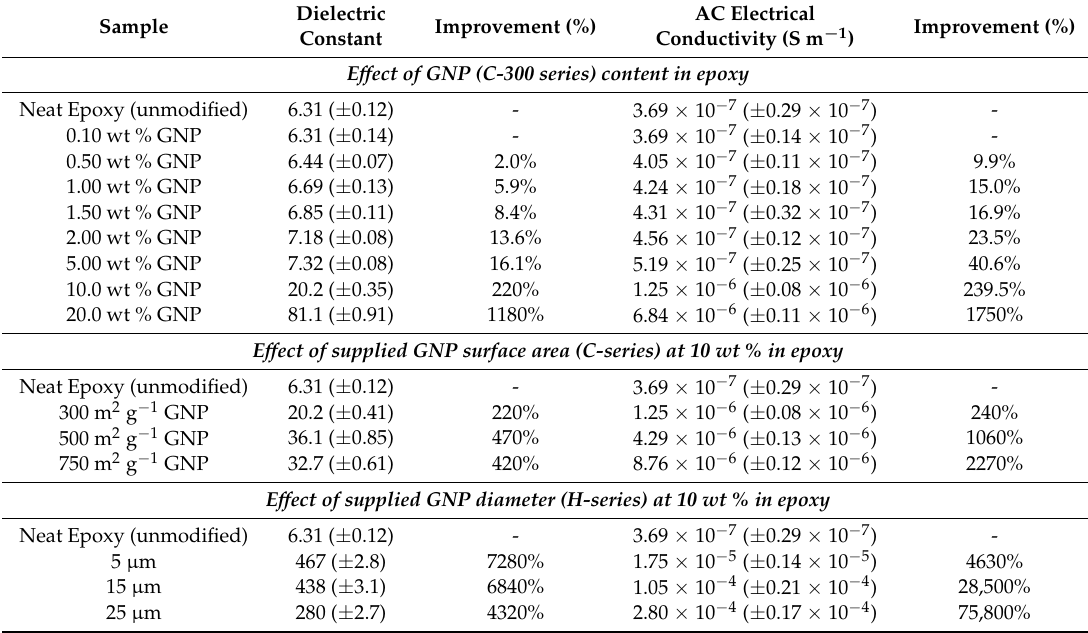
Table 1. Dielectric constant and AC electrical conductivity properties of epoxy GNP composites at an applied frequency of 10 3